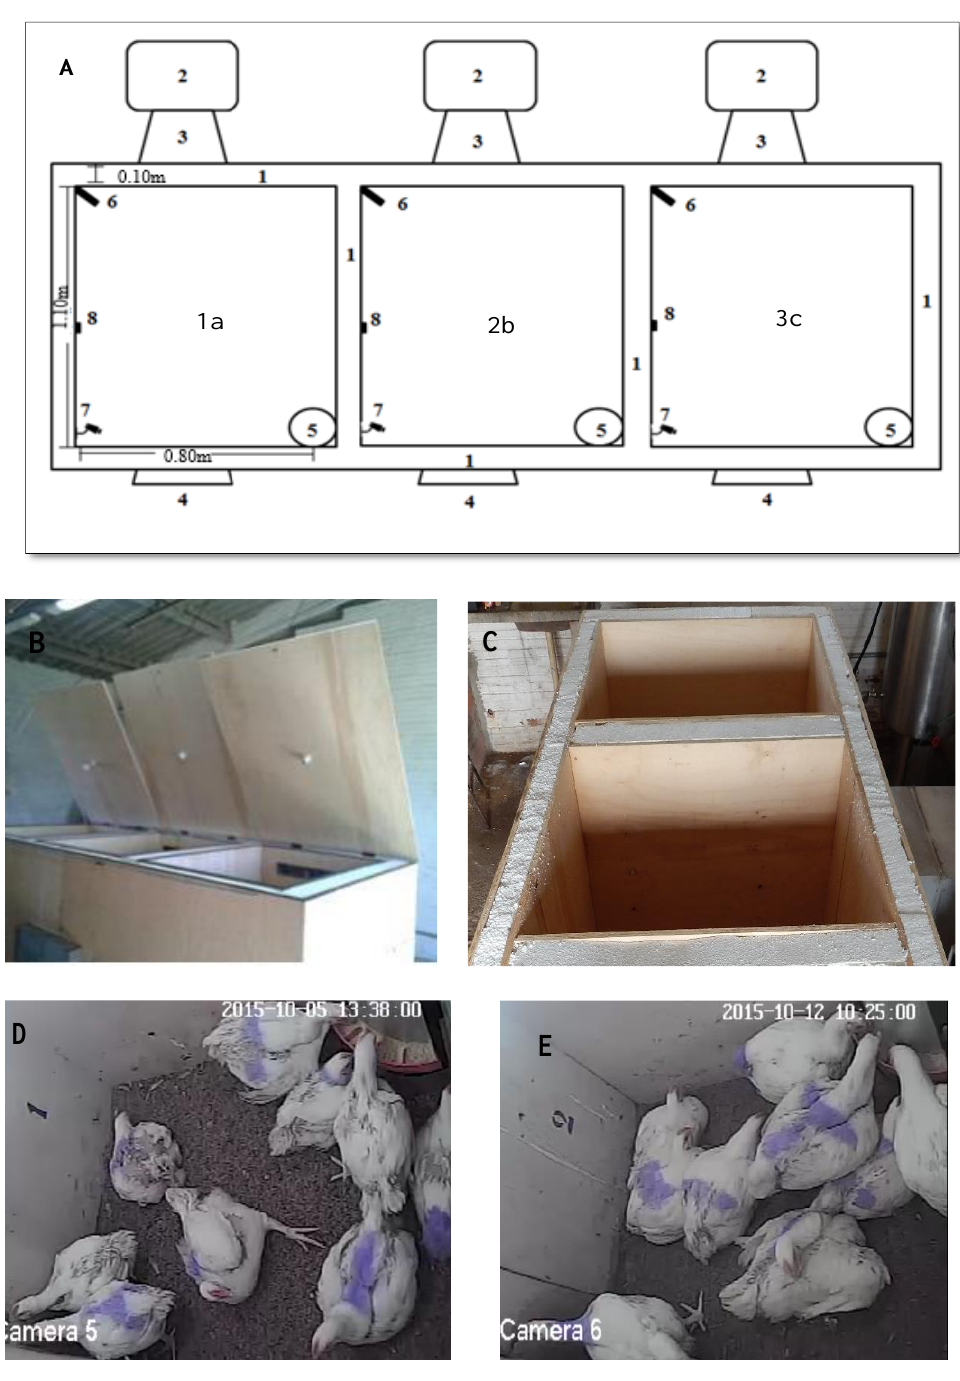
Figure 1. ( A ) Scheme of climate chambers. (1a: Chamber with high temperature; 2b: Chamber with comfort temperature; 3c: Chamber without experiment; 1: Internal polystyrene insulation; 2: Air conditioning; 3: Air intake; 4: Air outlet; 5: Feeder; 6: Drinker; 7: Video camera; 8: Datalogger and thermometer sensor). ( B ) External view of the climatic chamber and ( C ) inner part (under construc- tion) showing the seal. ( D ) Internal view of the cameras with the birds at 35 d old and exposed to heat stress. ( E ) Internal view of the cameras with the birds at 42 d old exposed to thermoneutral temperature.